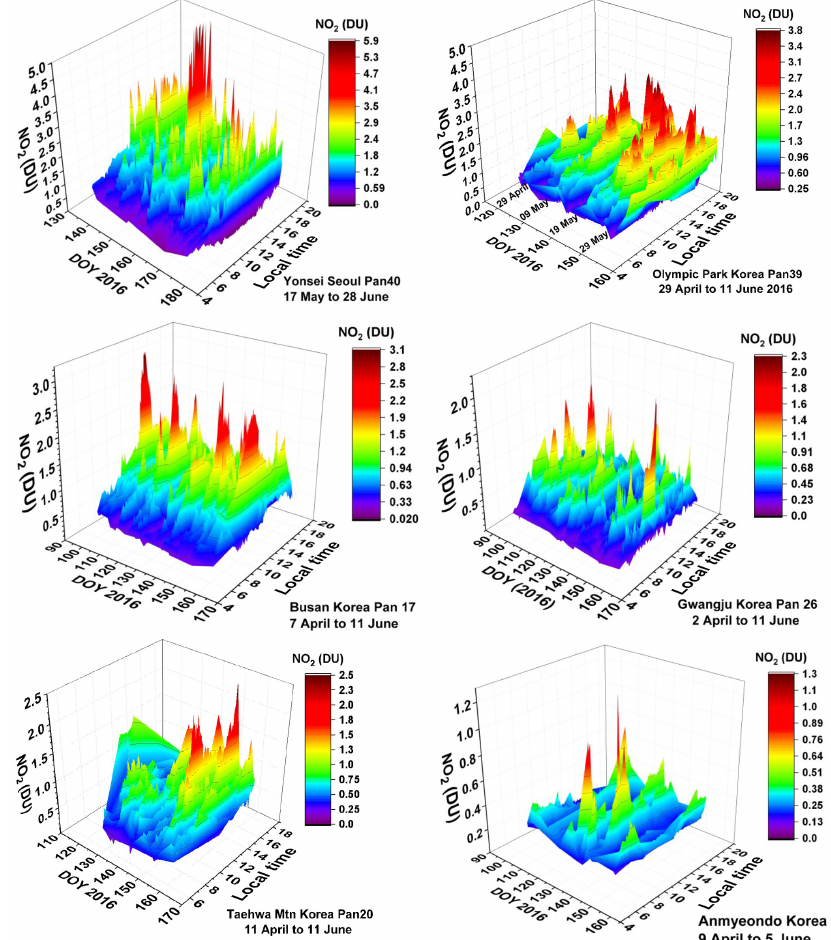
Figure 5. NO 2 amounts vs. day of the year (DOY) and local time (KST) for six sites as labeled in each panel. Day 120 is 29 April, Day 130 is 9 May, Day 140 is 19 May, Day 150 is 29 May, Day 160 is 8 June, Day 170 is 18